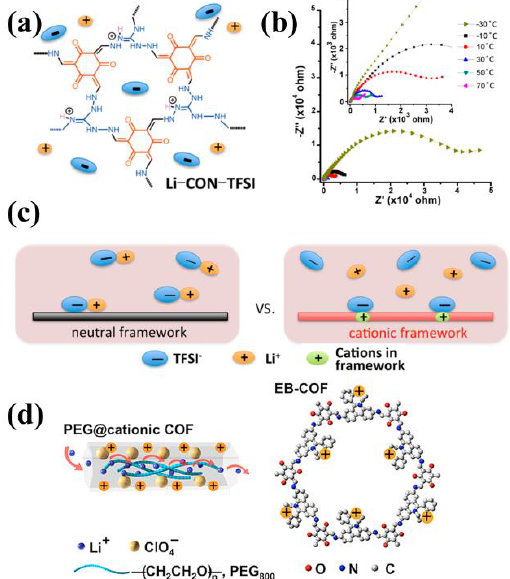
Figure 9. ( a ) Structure of the CONs with cationic framework for Li + conduction; ( b ) EIS of Li − CON − TFSI at different temperatures; ( c ) Schematic illustrations of ion association in COFs with neutral and cationic frameworks, respectively. Reproduced with permission from Ref. [60], Copyright (2018), American Chemical Society; ( d ) Schematic illustrations of Li + transport in EB − COF. Reproduced with permission from Ref. [48], Copyright (2018), American Chemical Society.